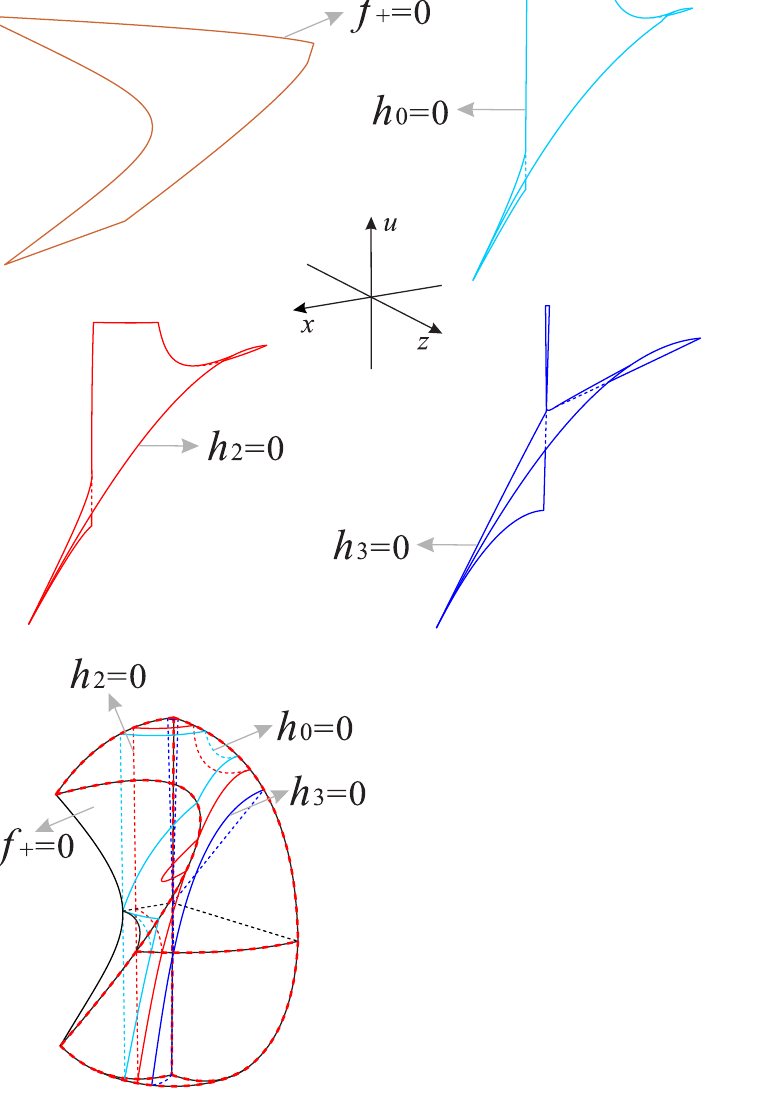
Figure 31. The surfaces h 0 , h 2 and h 3 restricted to the surface f + ( x , z , u ) = 0 and the region Q 1 of the Poincaré